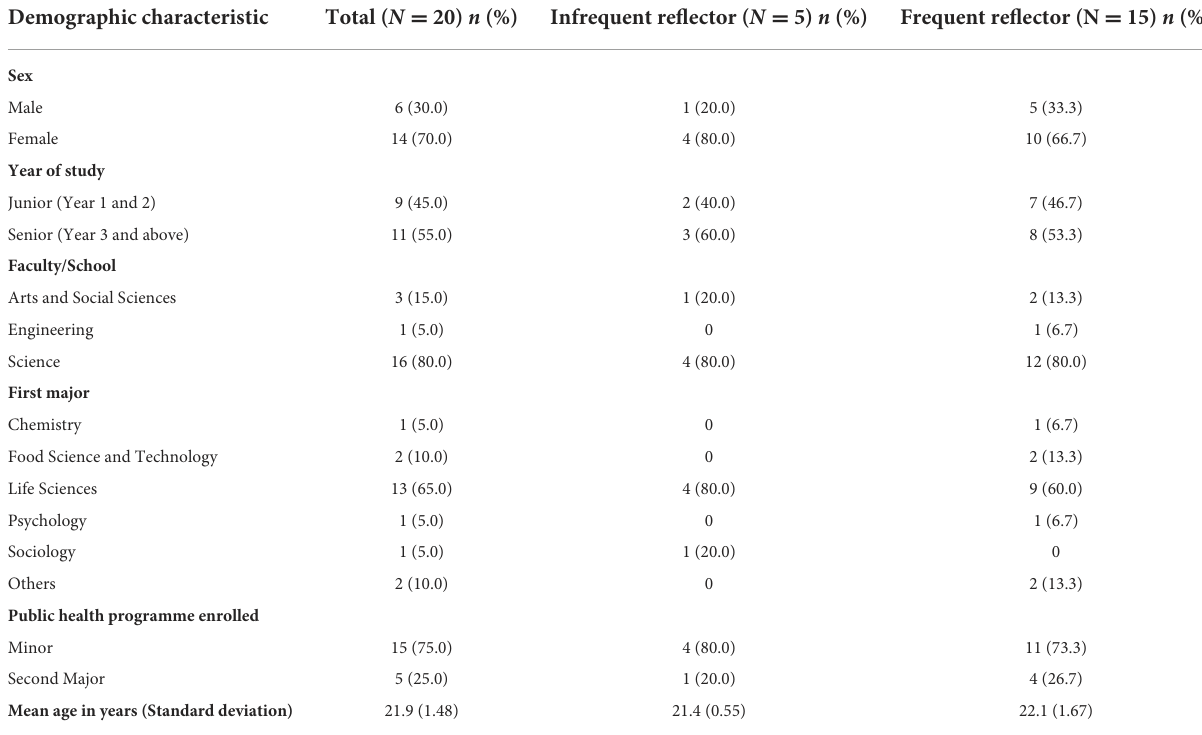
TABLE 4 Demographic characteristics of participants for in depth